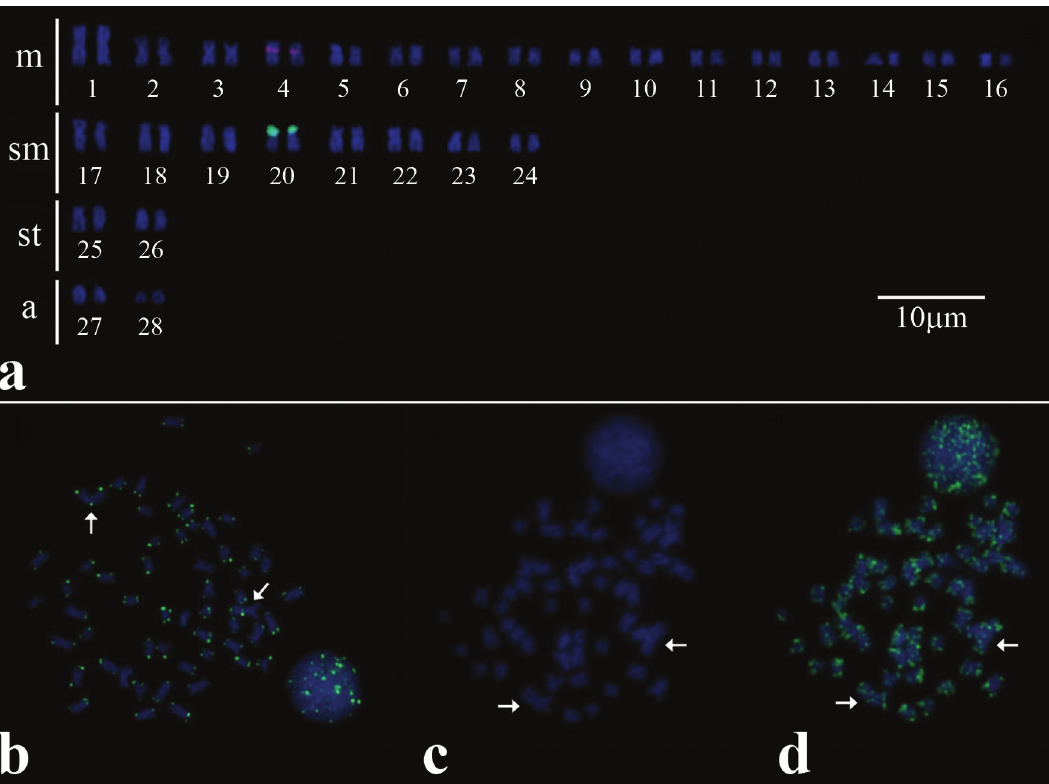
Fig. 2. Karyotype of Ageneiosus inermis hybridized with ( a ) 5S rDNA (digoxigenin, red) and 18S rDNA (FITC, green). Metaphases of Ageneiosus inermis hybridized with ( b ) [TTAGGG] the metacentric chromosomal pair 1, which was originated by